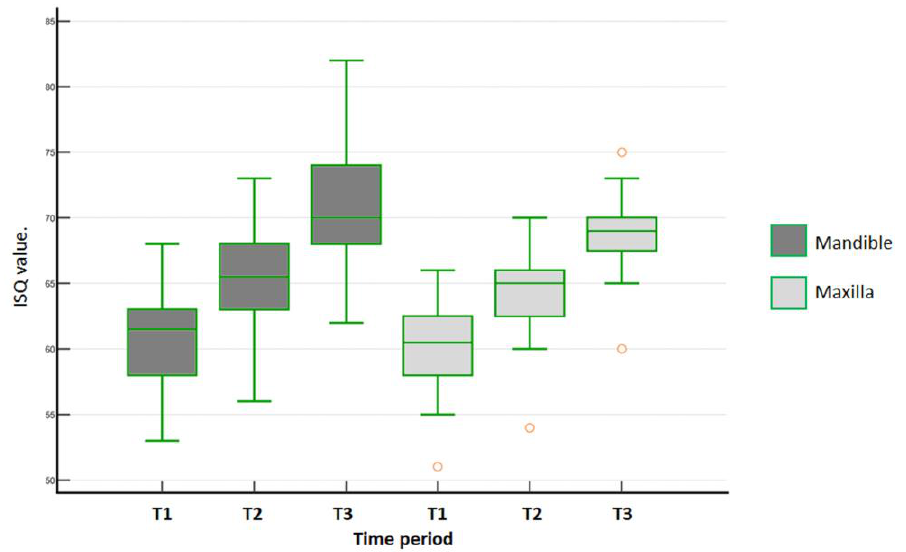
Figure 6. Data distribution of B-L ISQ values measured for DC group within each arch in each time period (T1 = baseline; T2 = 30 days; and T3 = 45 days). Outlier values are indicated in